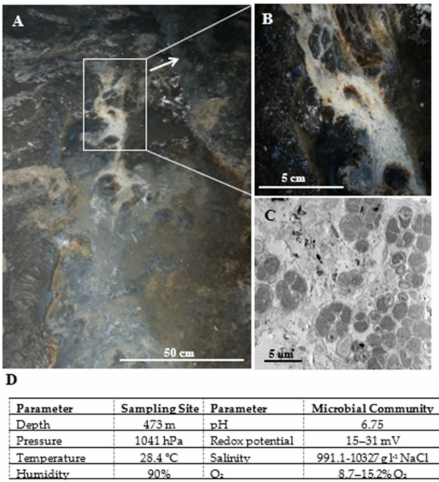
Figure 1. View of the microbial mat sampling site in Lubin mine ( A ). Enlarged view of the of microbial mat ( B ). Transmission electron microphotograph of an ultrathin section of the microbial mat ( C ). Physicochemical characteristics of the sampling site and the studied microbial community ( D